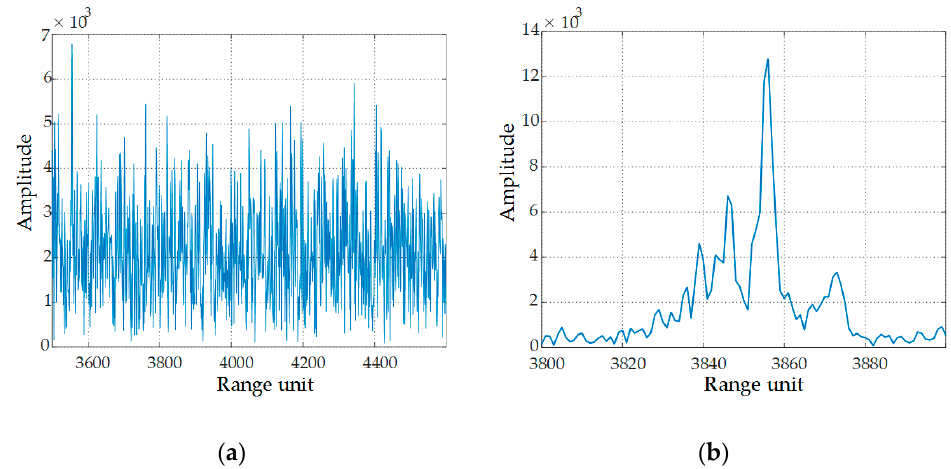
Figure 21. ( a )The signal before processing; ( b ) Reconstructed HRRP of the target.